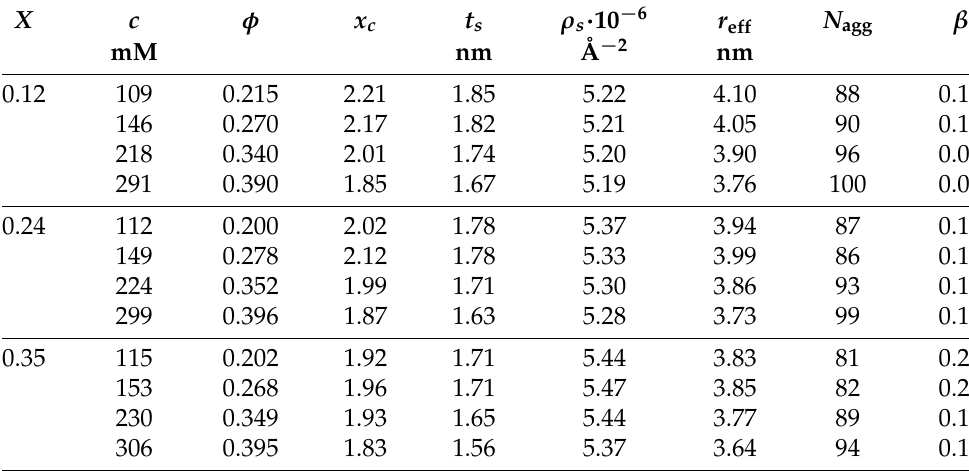
Table 5. Parameters extracted from SANS model fits (core-shell ellipsoid form factor +